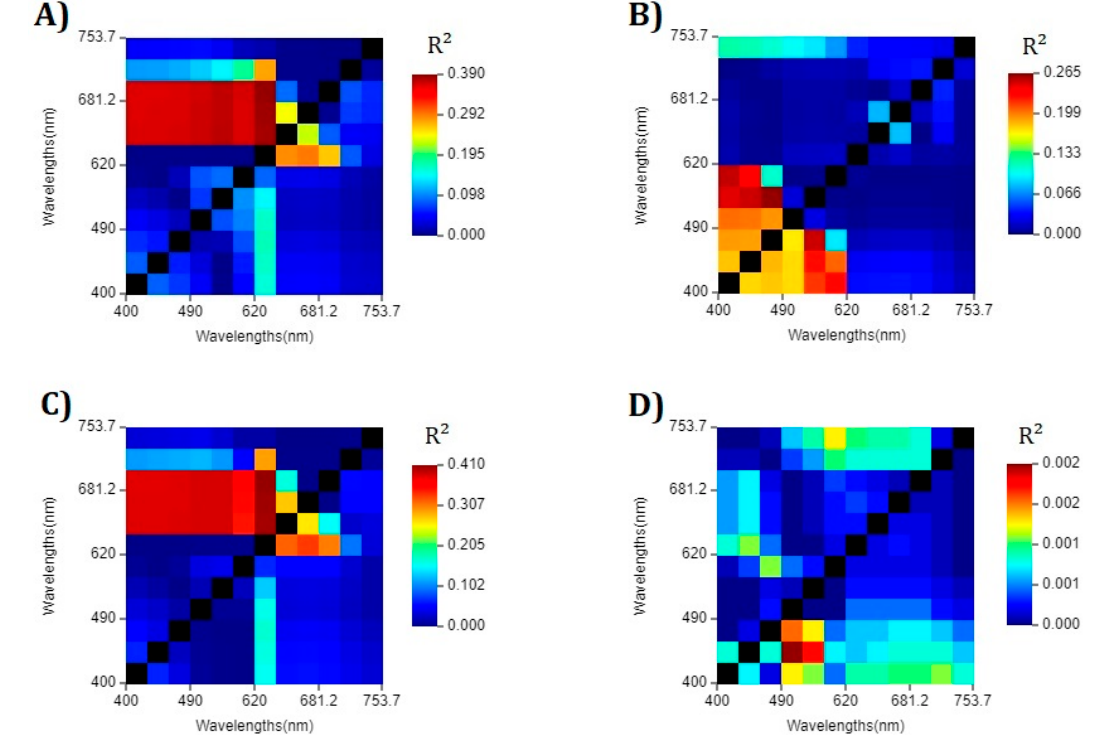
Figure 4. 2D color R 2 plots for PC concentration estimation ( A ) R 2 values for all data; ( B ) R 2 values for the day before the field sampling data; ( C ) R 2 values for same day of the field sampling data, and ( D ) R 2 values for the day after the field sampling data.